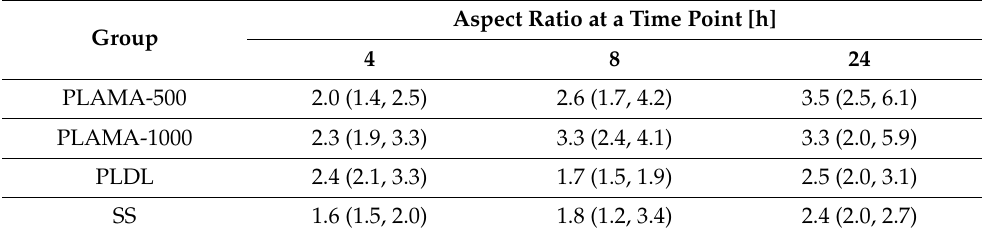
Table 10. Numerical results of the cell morphology test: aspect ratio of cells.